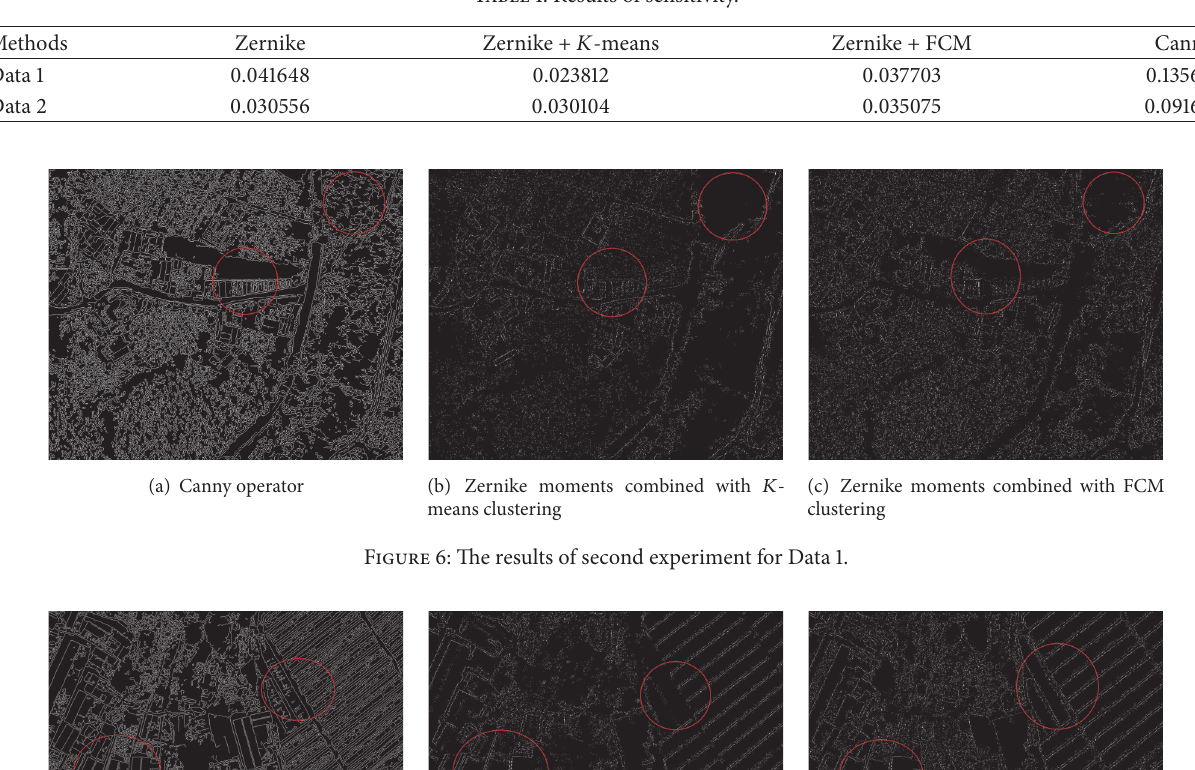
Table 1: Results of sensitivity.